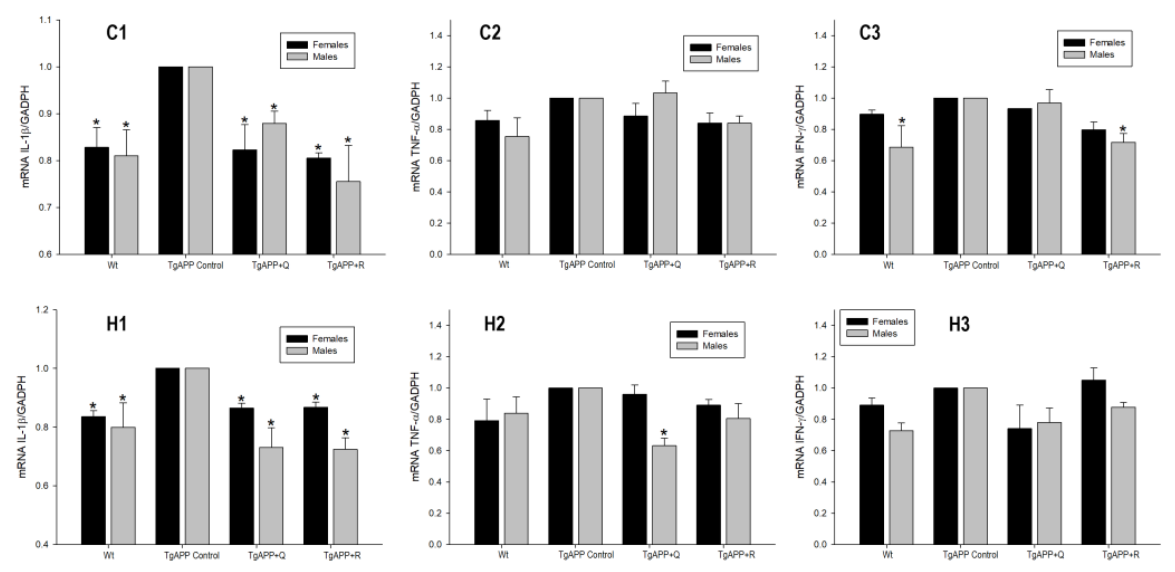
Figure 9. Effect of quercetin (Q) and rutin (R) on IL- 1β (C1, H1), TNF - α (C2, H2), and IFN- γ (C3, H3) expression in the cortex (C) and the hippocampus (H). (1) WT; (2) TgAPP control; (3) TgAPP + Q; (4) TgAPP + R. * p < 0.05 vs. TgAPP control.